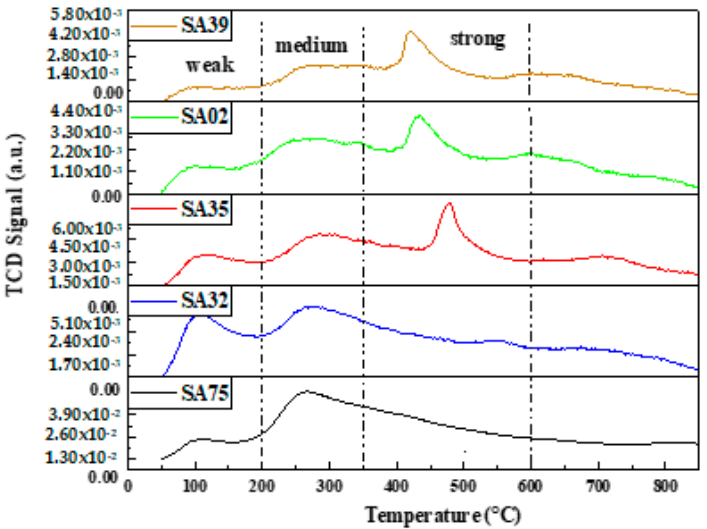
Figure 5. Fresh CO 2 -TPD analysis of Ni-supported